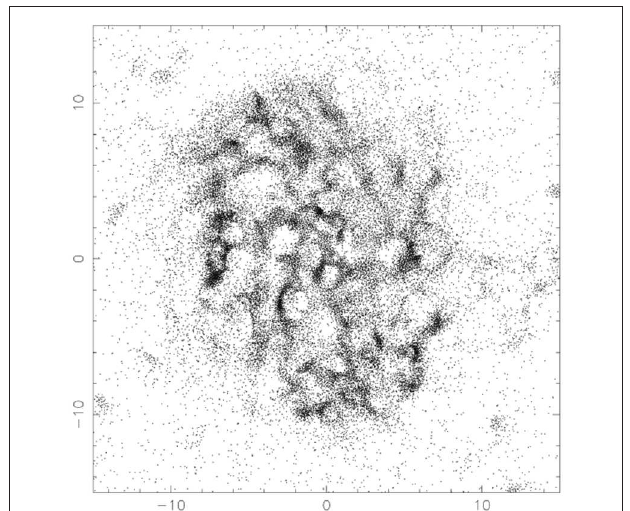
FIGURE 9 | Neutral hydrogen particles in a disk galaxy in the Eagle simulations. Observed HI images can be compared, such as the LMC (Kim and Park, 2007 ), which shows such structure, and M31 (Braun, 1990).